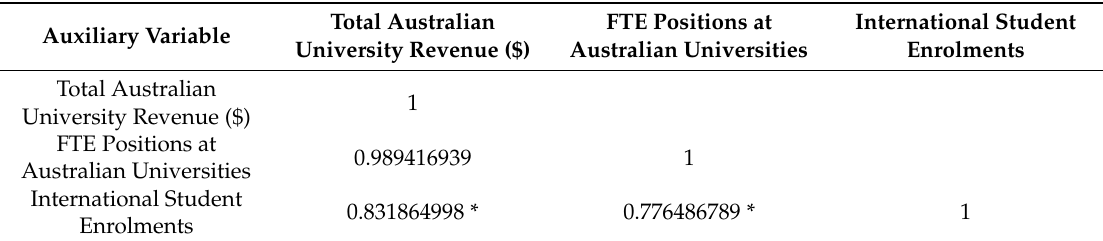
Table 3. Results of Correlation